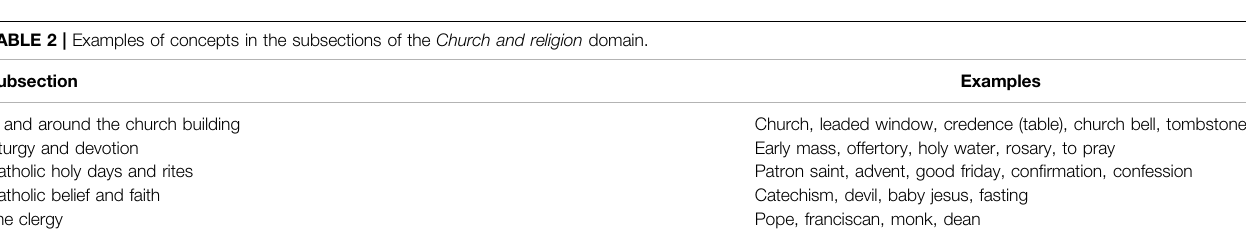
TABLE 2 | Examples of concepts in the subsections of the Church and religion domain.